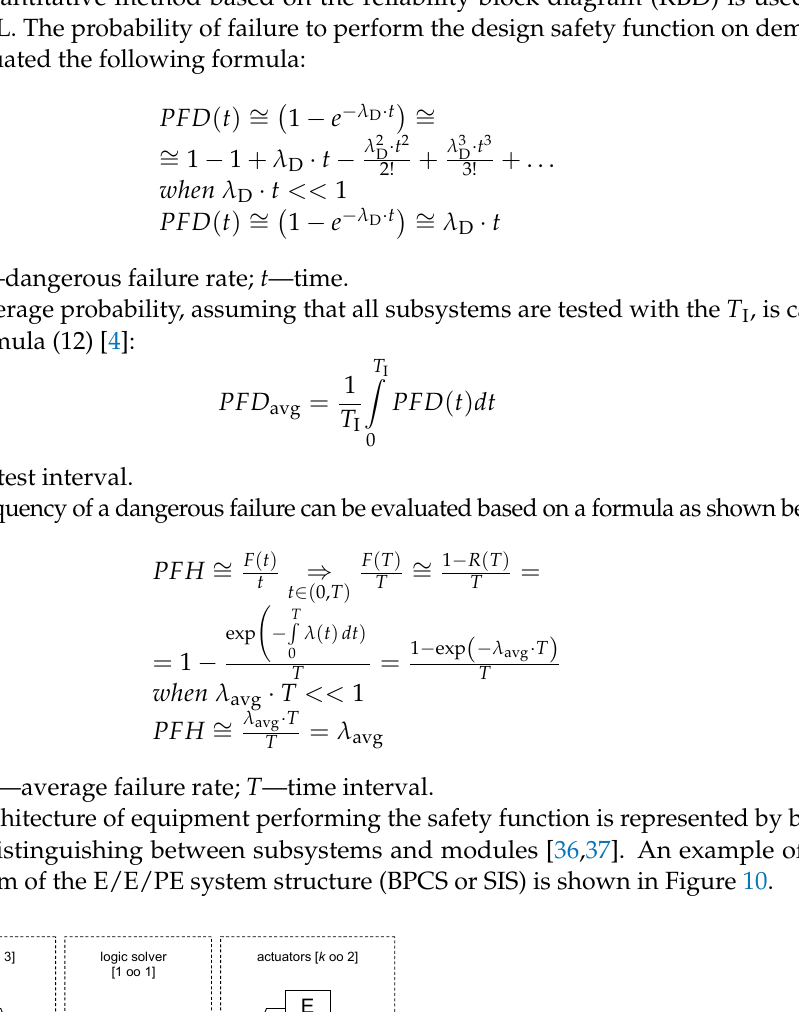
Figure 11. Reliability block diagram RBD of an example E/E/PE or SIS system structure. In the above diagram the common cause failure (CCF) for the sensors’ subsystem from elements A, B and C and for the actuators’ subsystem CCF2 from elements E and F is considered [4,36,38]. In the system from Figure 10, five minimum cuts can be distin- guished: {A, B, C}; {CCF1}; {D}; {E, F}; {CCF2} Figure 12 shows the E/E/PE or SIS system fault tree from Figure 11 including the common cause failure.